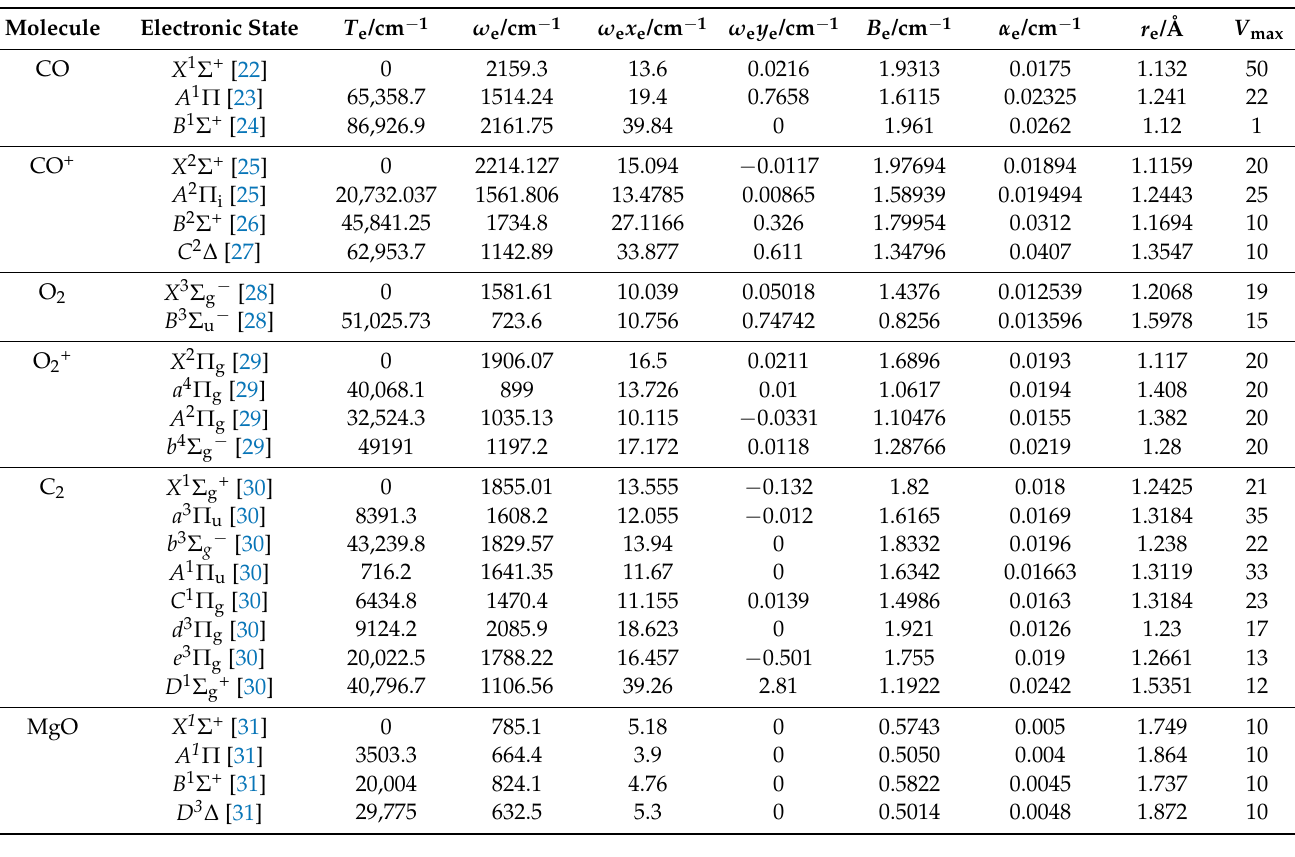
Table 3 lists the spectroscopic constants for different energy levels of the diatomic molecules. Table 3. The spectroscopic constants for different energy levels of diatomic